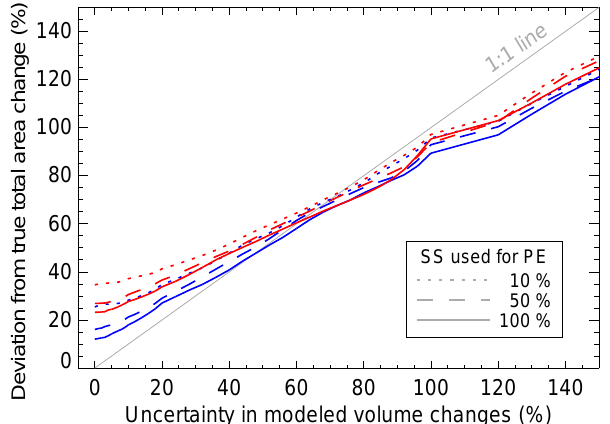
Fig. 4. Accuracy (95% of confidence) with which the true total area change between two points in time t 1 and t 2 can be recovered by using volume–area scaling if the volume change between t 1 and t 2 can be estimated within a given uncertainty. Blue (red) lines refer to the situation in which both t 1 and t 2 refer to steady-state (tran- sient) geometries. The different line styles depict different subsam- ple sizes used for parameter estimation (SS used for PE). The total glacier population is fixed to 500 glaciers. The 1 : 1 line is given as a